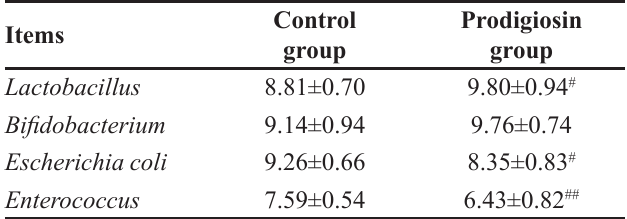
TABLE III ‑ The effects of PG on the caecal microflora in weaned rats lg(CFU/g)